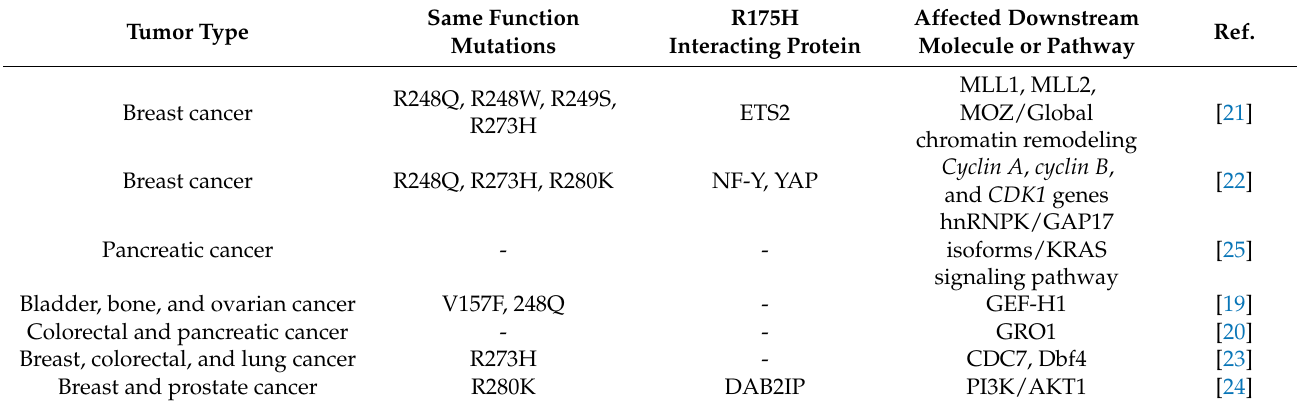
Table 3. Summary of p53-R175H gain-of-function of promoting cancer cell